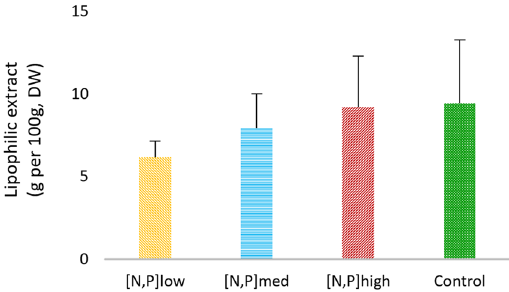
Figure 1. Total amount of the lipid extract of Halimione portulacoides leaves. Error bars represent standard